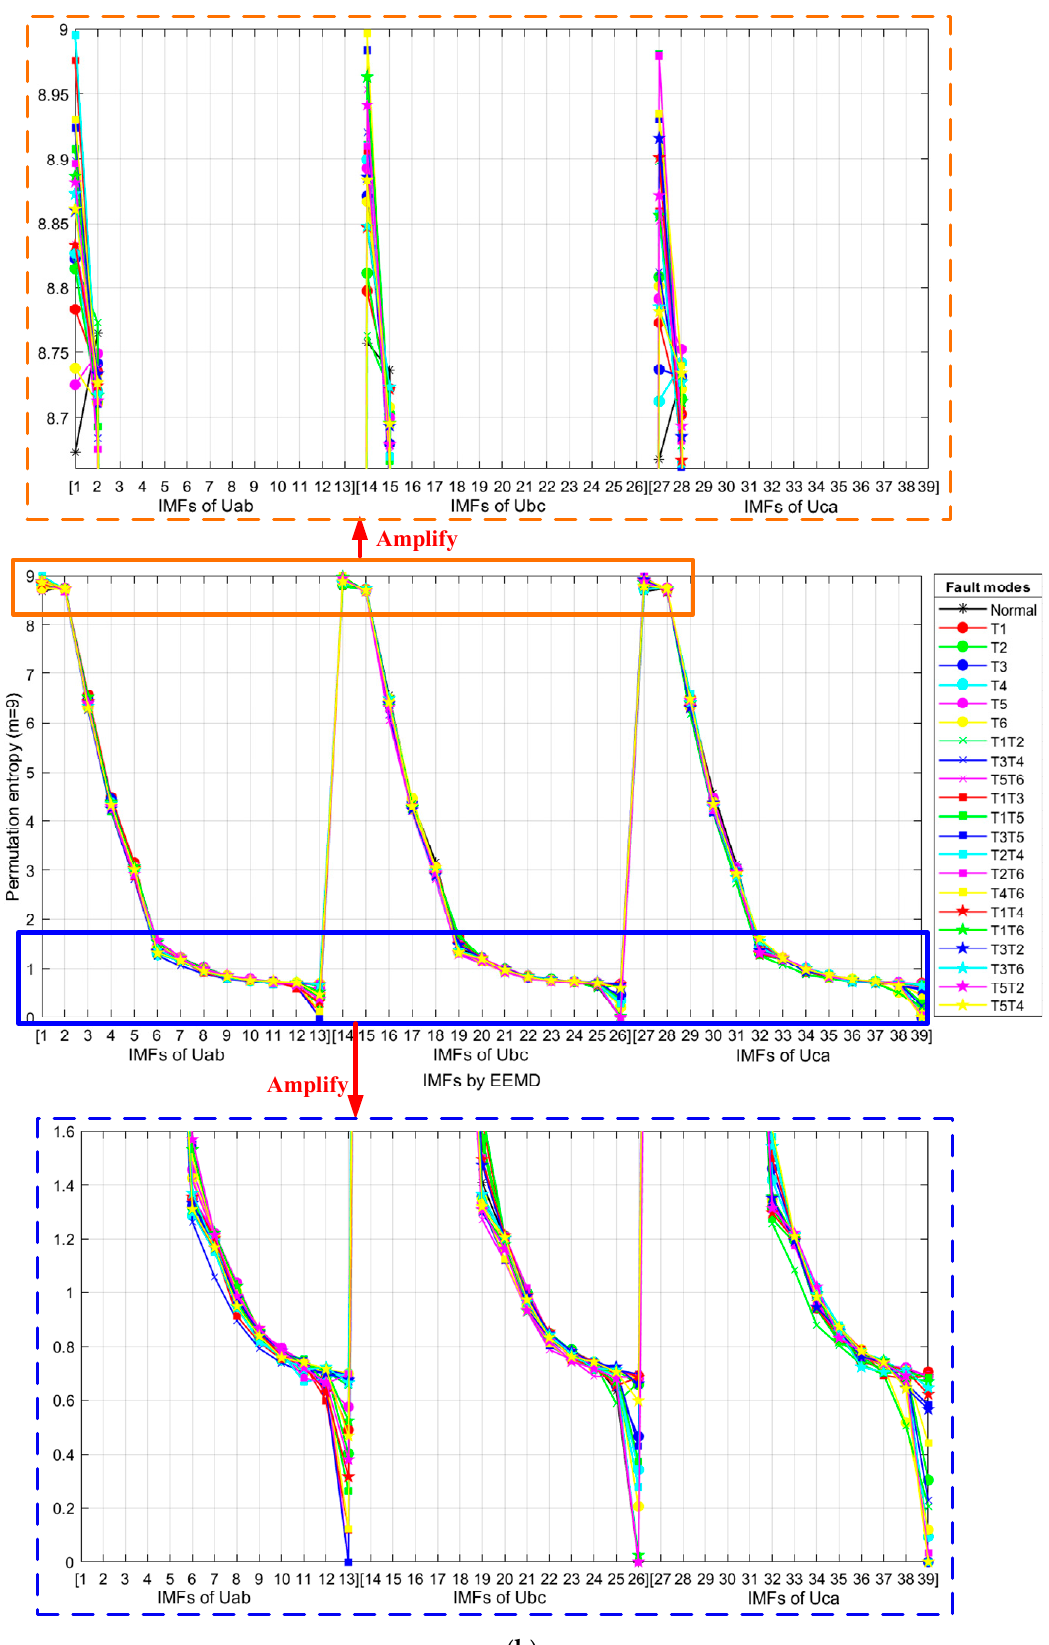
Figure 6. Permutation entropy of 22 fault modes of the converter. ( a ) m = 3; ( b ) m = 9.